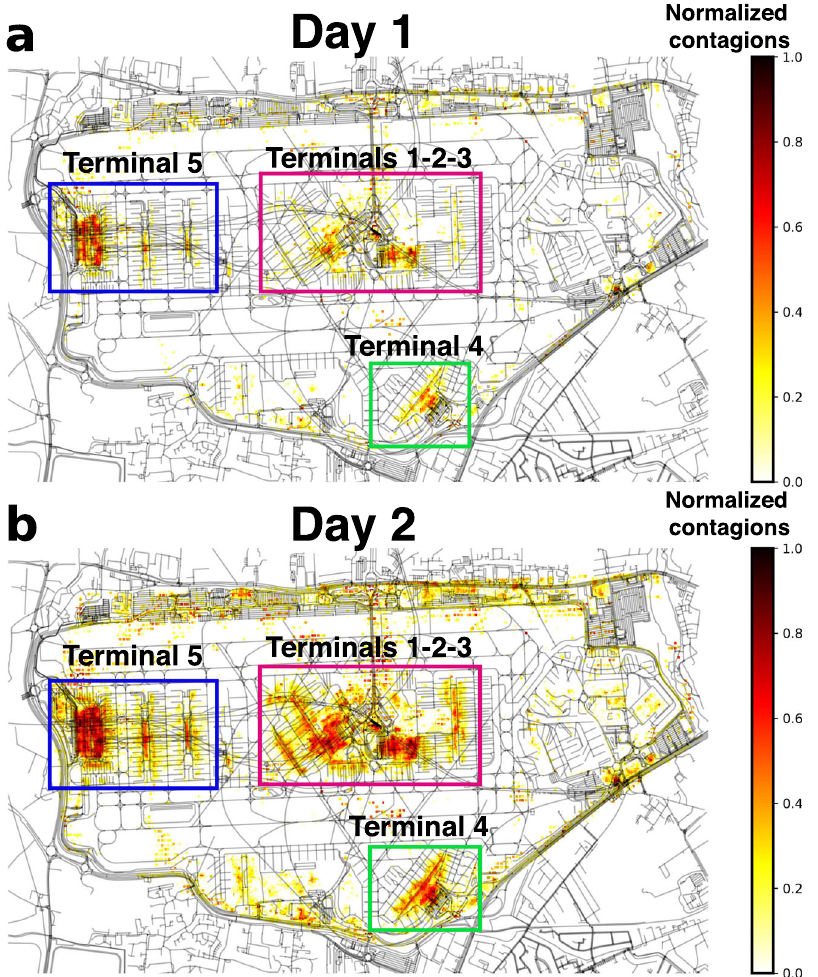
Fig. 2 | Density of contagions in space. Heatmap showing the cells in the airport area in which contagions occur when running the SIR model. In a , after one day of simulation and in b after two days. Color code normalized for each period